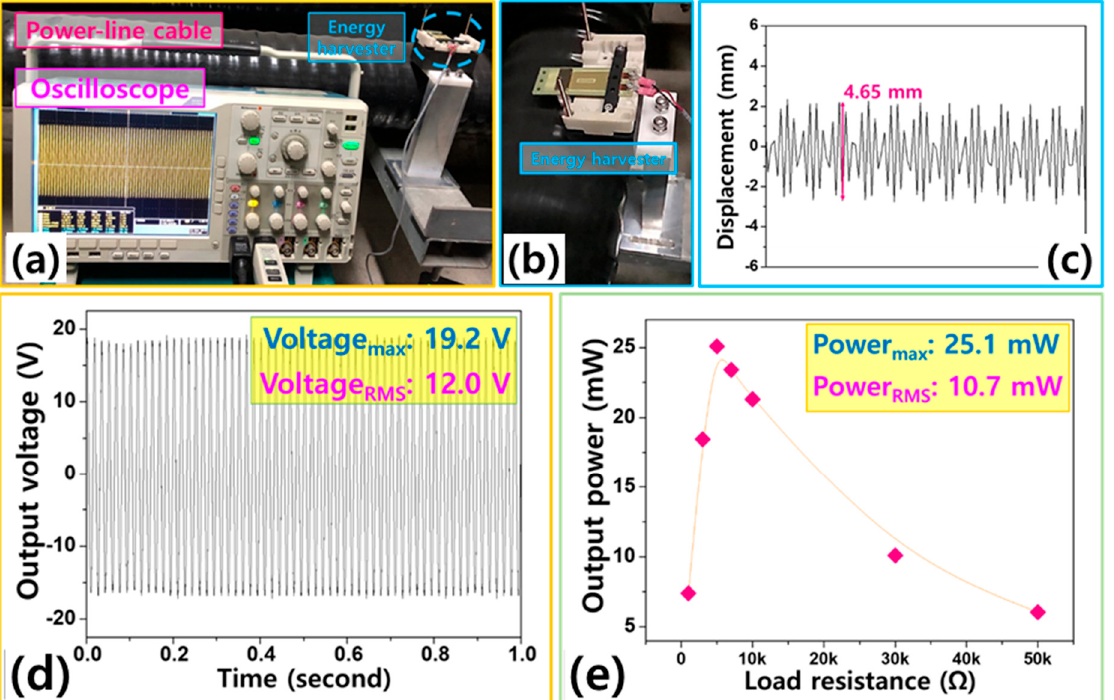
Figure 6. ( a ) Actual photo of the experimental setup with a ×4 harvester with the actual magnetic field of a power-line cable. ( b ) Photograph of the piezo-energy harvester for scavenging the magnetic field of an AC power-line cable. ( c ) Displacement (mm) of the tip mass under an ambient magnetic field from the power-line cable. ( d ) Output voltage (V) of the ×4 harvester generated by the magnetic field of power-line cable. ( e ) Output power (mW) of the ×4 harvester generated under various load resistances.